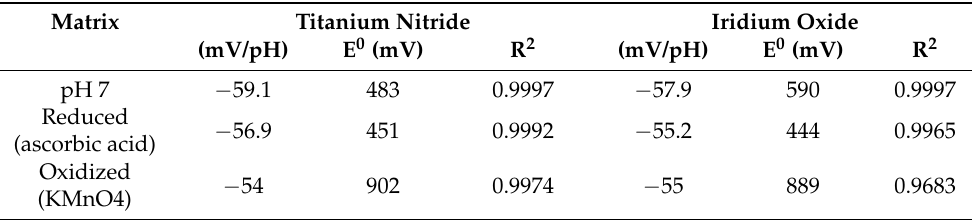
Table 7. Sensitivity (mV/pH) and E 0 values for 85 nm TiN electrode, after exposure to pH 7 buffer, 1 mM KMnO4 (oxidized) and 1 mM ascorbic acid